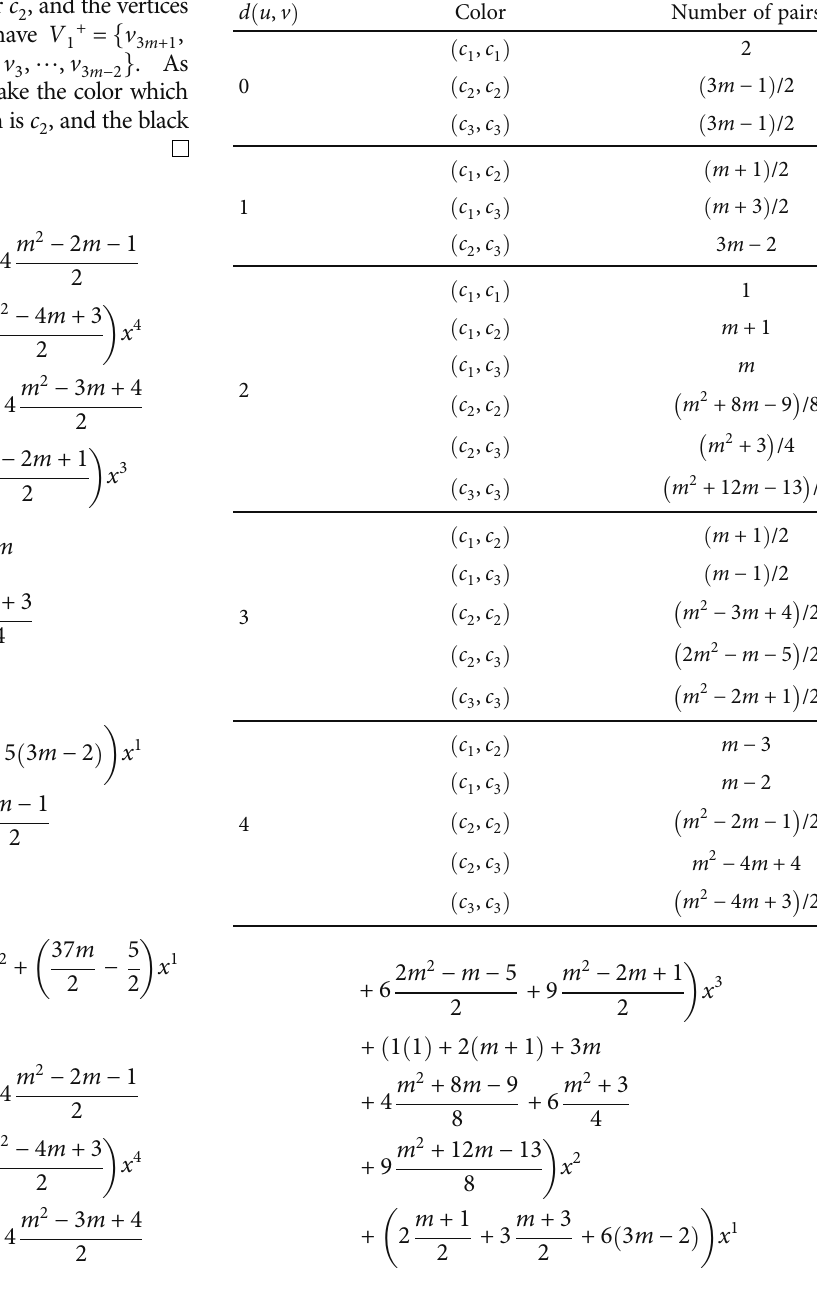
Figure 4: Jahangir graph J Table 3: Shows the distance sequence in Jahangir graph J